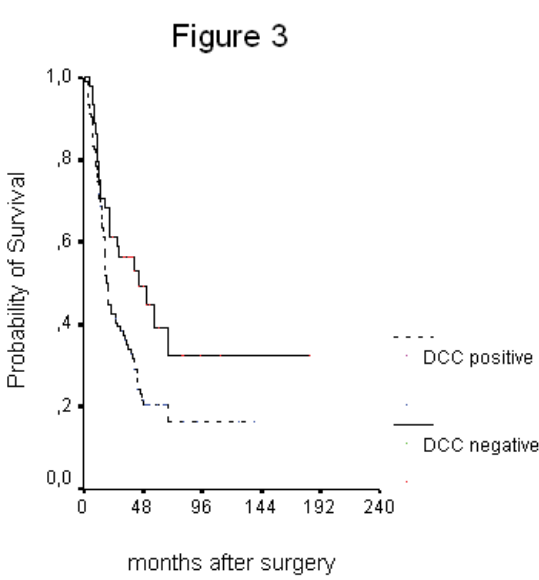
Figure 3. Overall survival (OS) after resection of gastric cancer according to DCC